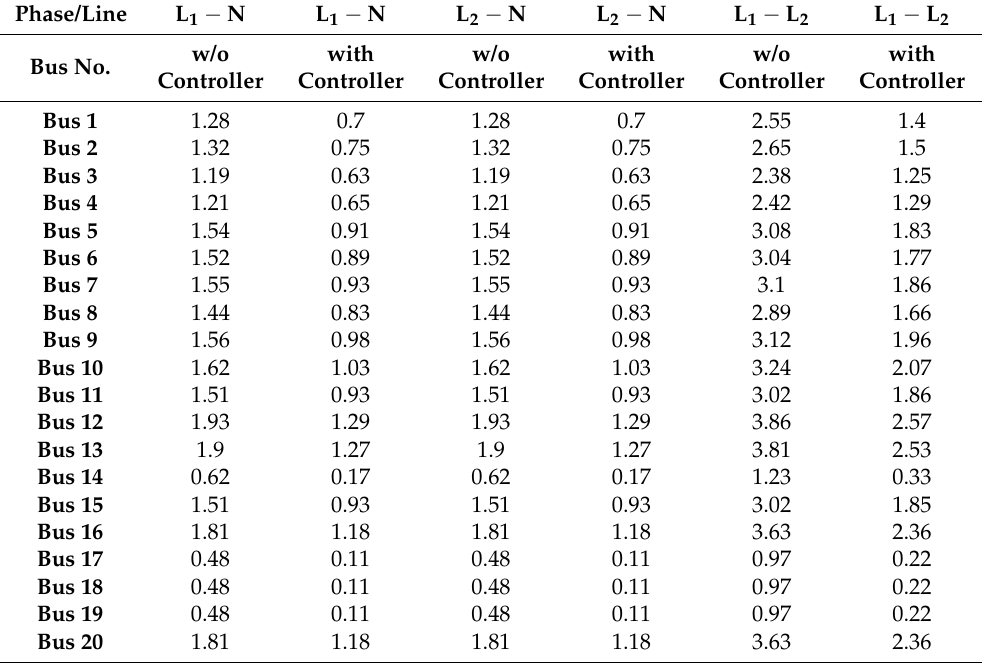
Table 7. Root mean square deviation in voltages in scenario 3 with and without the proposed method. Phase/Line with